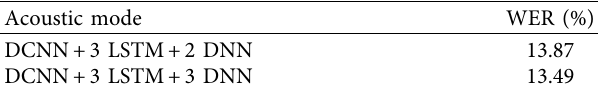
Table 6: Results of DNN with different number of layers on